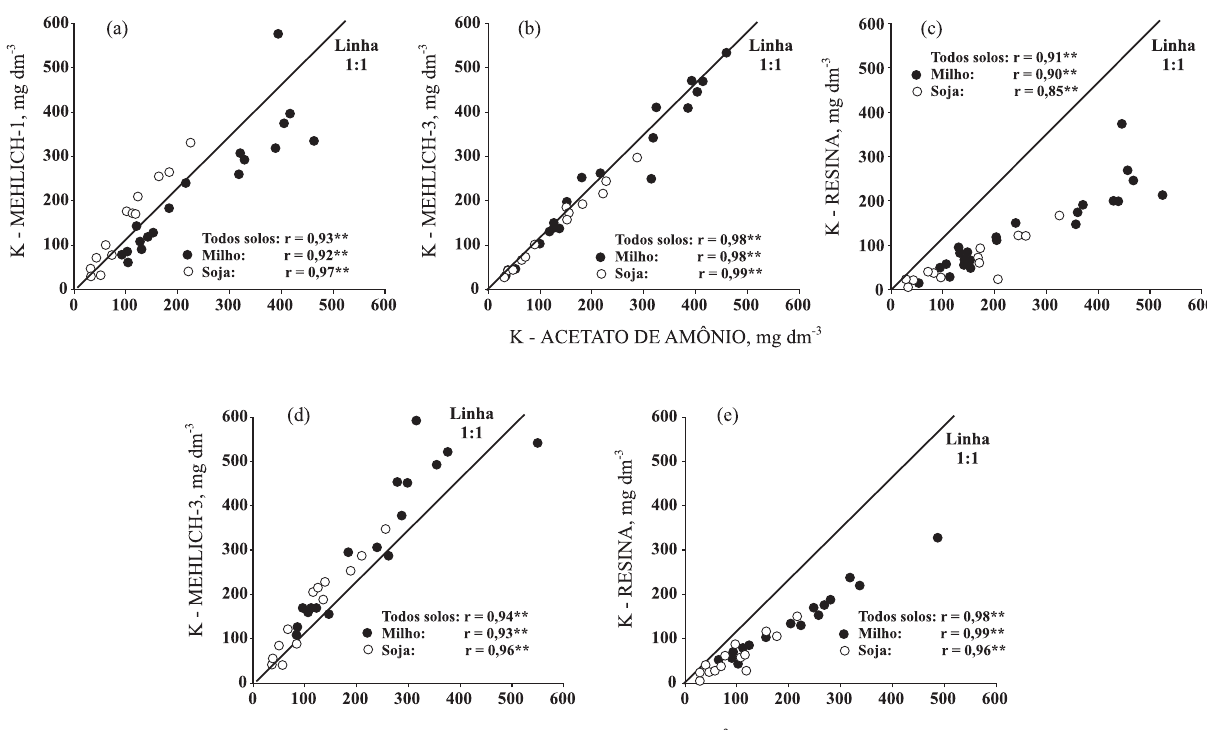
Figura 1. Correlação entre os teores de potássio extraídos pelos métodos em amostras de solos coletadas antes do primeiro, com milho, e do segundo cultivo, com